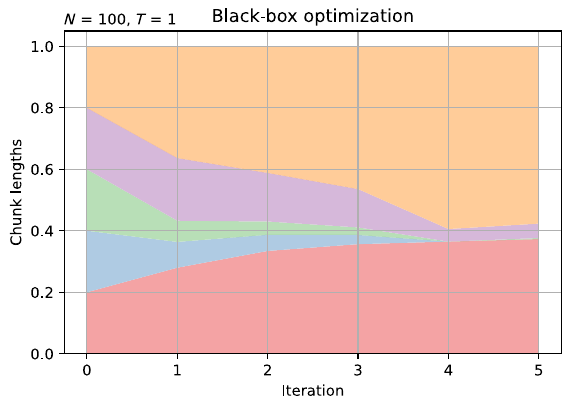
FIG. 12. Stacked chunk lengths adding to s = 1 display the evolution of an instance of a black-box optimizing routine. The chunks are initialized with equal lengths and their lengths are optimized using a L-BFGS-B optimizer with regard to a maximal final fidelity with the ground state of the ZZXZ Hamiltonian. A confluence of chunks can be observed around s ≈